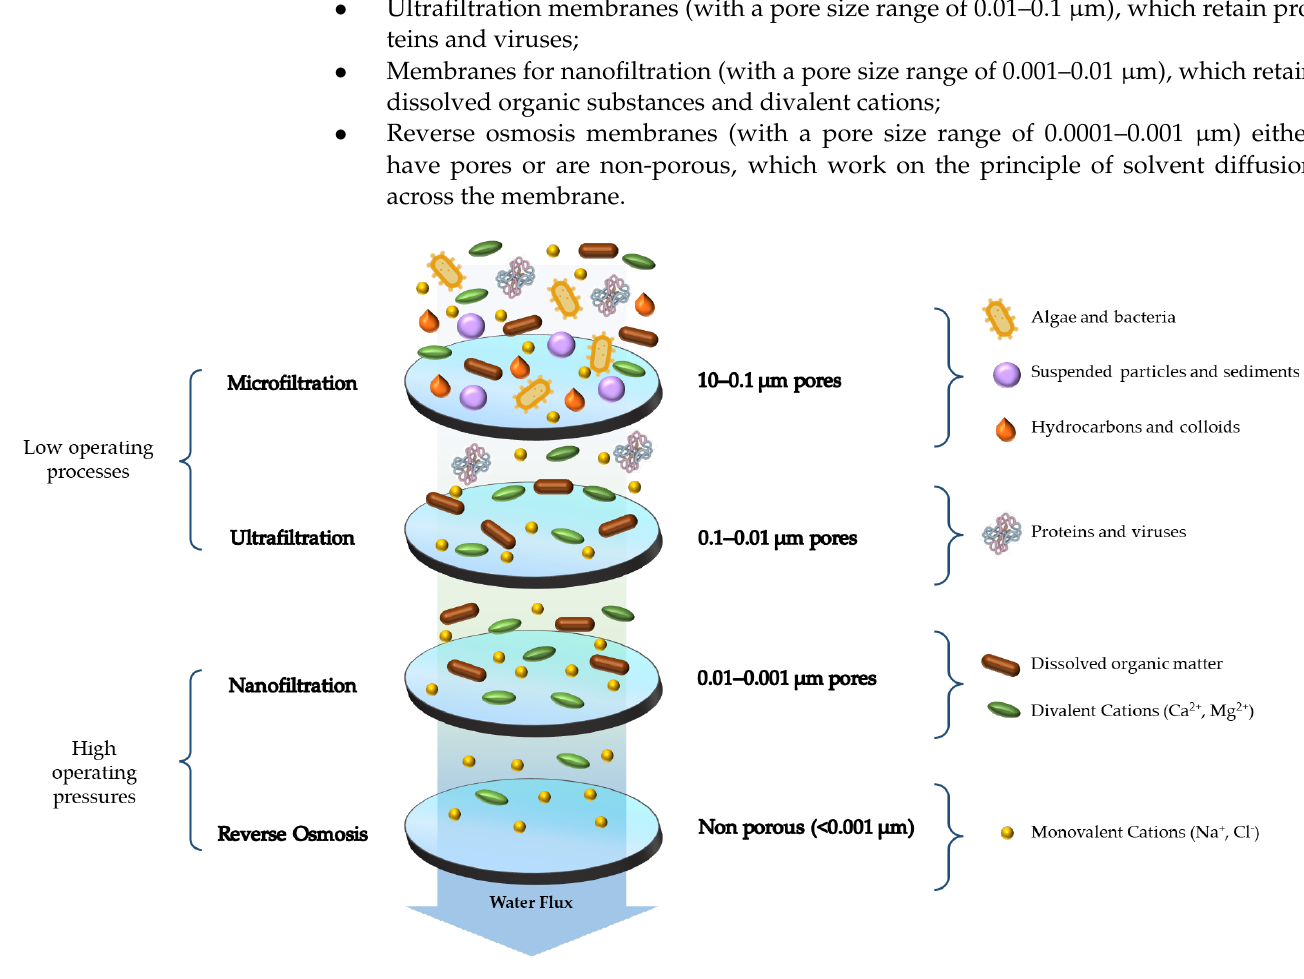
Figure 2. Representation of different membrane-based filtration processes with an example of the relative pollutant retention capabilities.